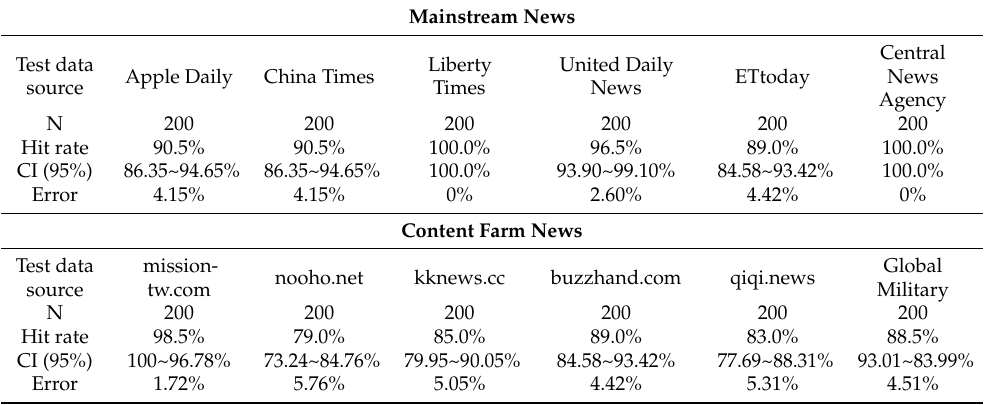
Table 3. The result of the BERT method for mainstream news and content farm